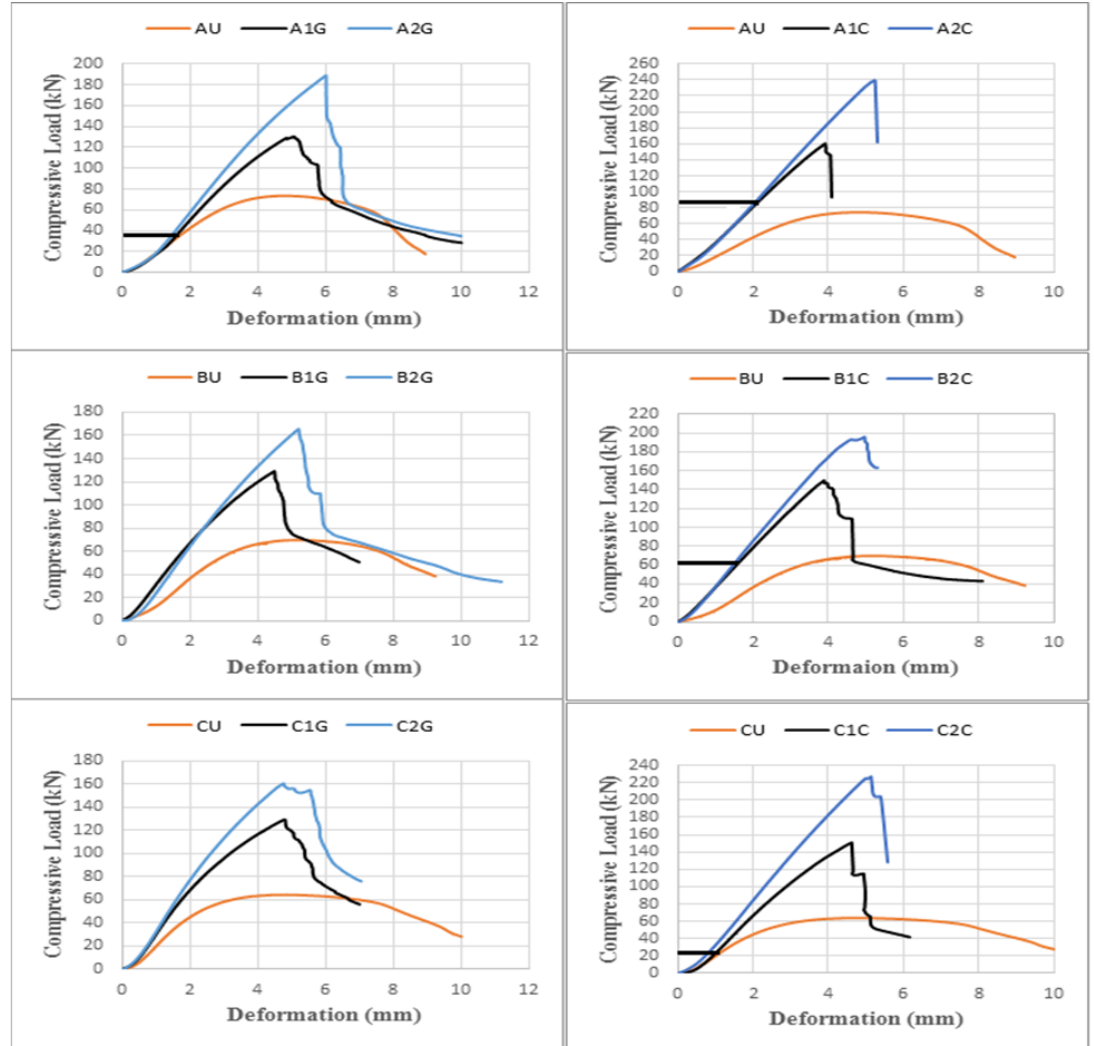
Figure 6: Graphs of load versus deformation of groups A (4+2 mm), B (3.18+1.4 mm) and C (2+1 mm) confined with GFRP and CFRP (Black lines indicate extent of shared path of curves)